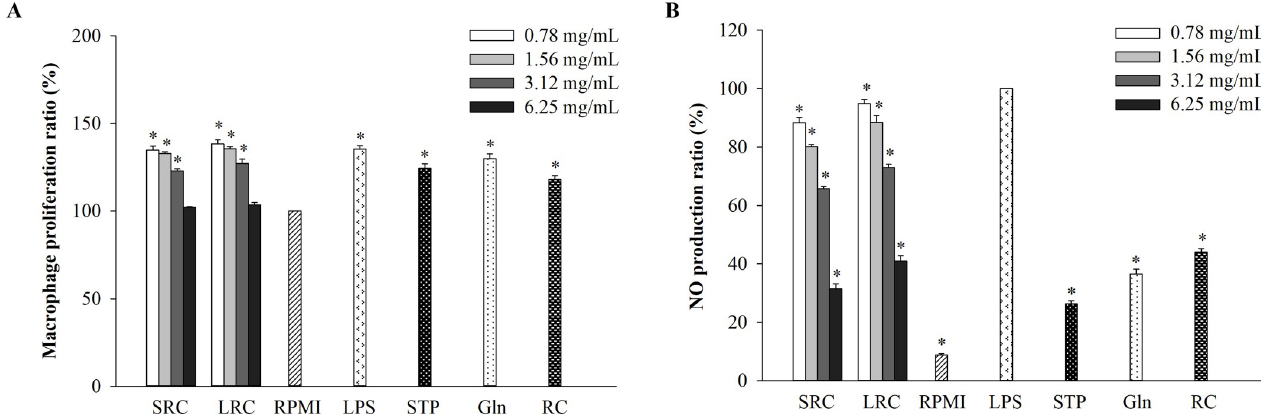
Fig 1. Effect of SRC and LRC on LPS-stimulated RAW264.7 macrophage cells. (A) Macrophage proliferation. (B) NO production. The results are presented as the mean ± SD ( n = 3). Significant differences are p < 0.05 compared with RPMI. SRC = strawberry rice cake, LRC = L-glutamine rice cake, STP = strawberry powder, L-glutamine = Gln and RC = rice